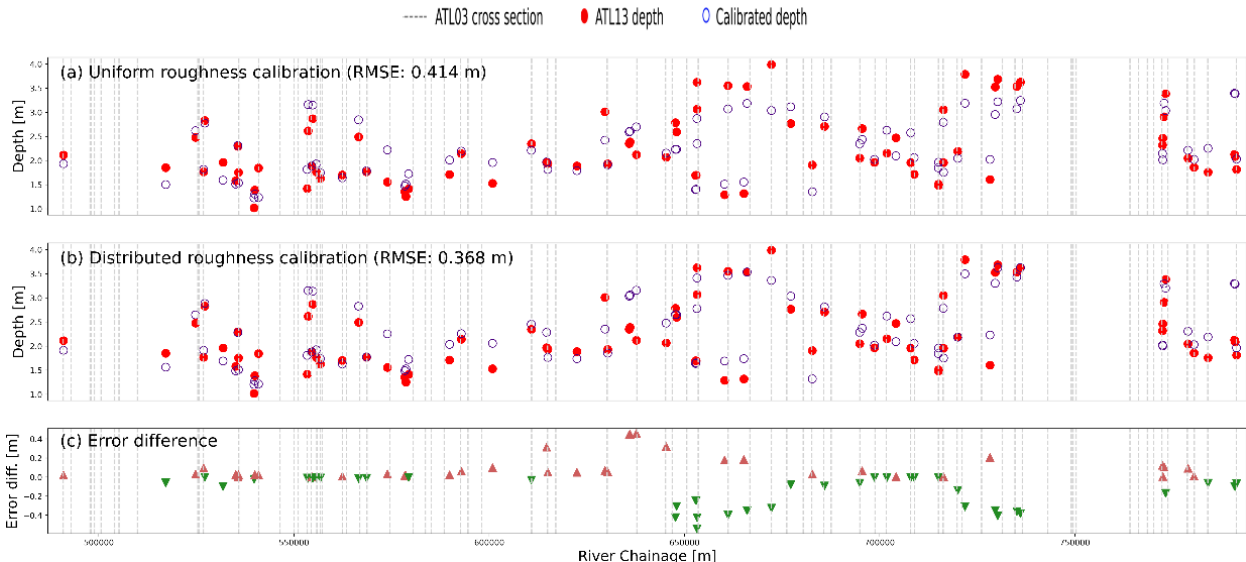
Figure A3. Uniform depth calibration (a) compared with distributed roughness calibration for 16 Manning’s roughness values (b) and the error difference between the uniform calibration and the distributed calibration (c) .